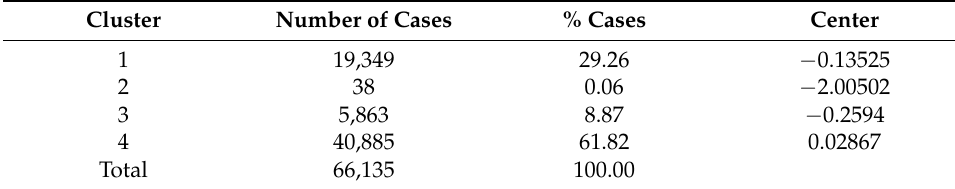
Table 4. Estimated coefficients of the independent variables (second multiple linear regression model). Parameter